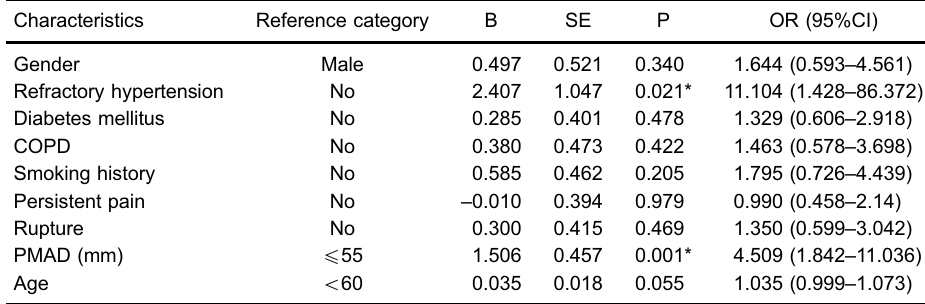
Table 2. Risk factors of long-term survival in patients with type-B aortic dissection. Characteristics